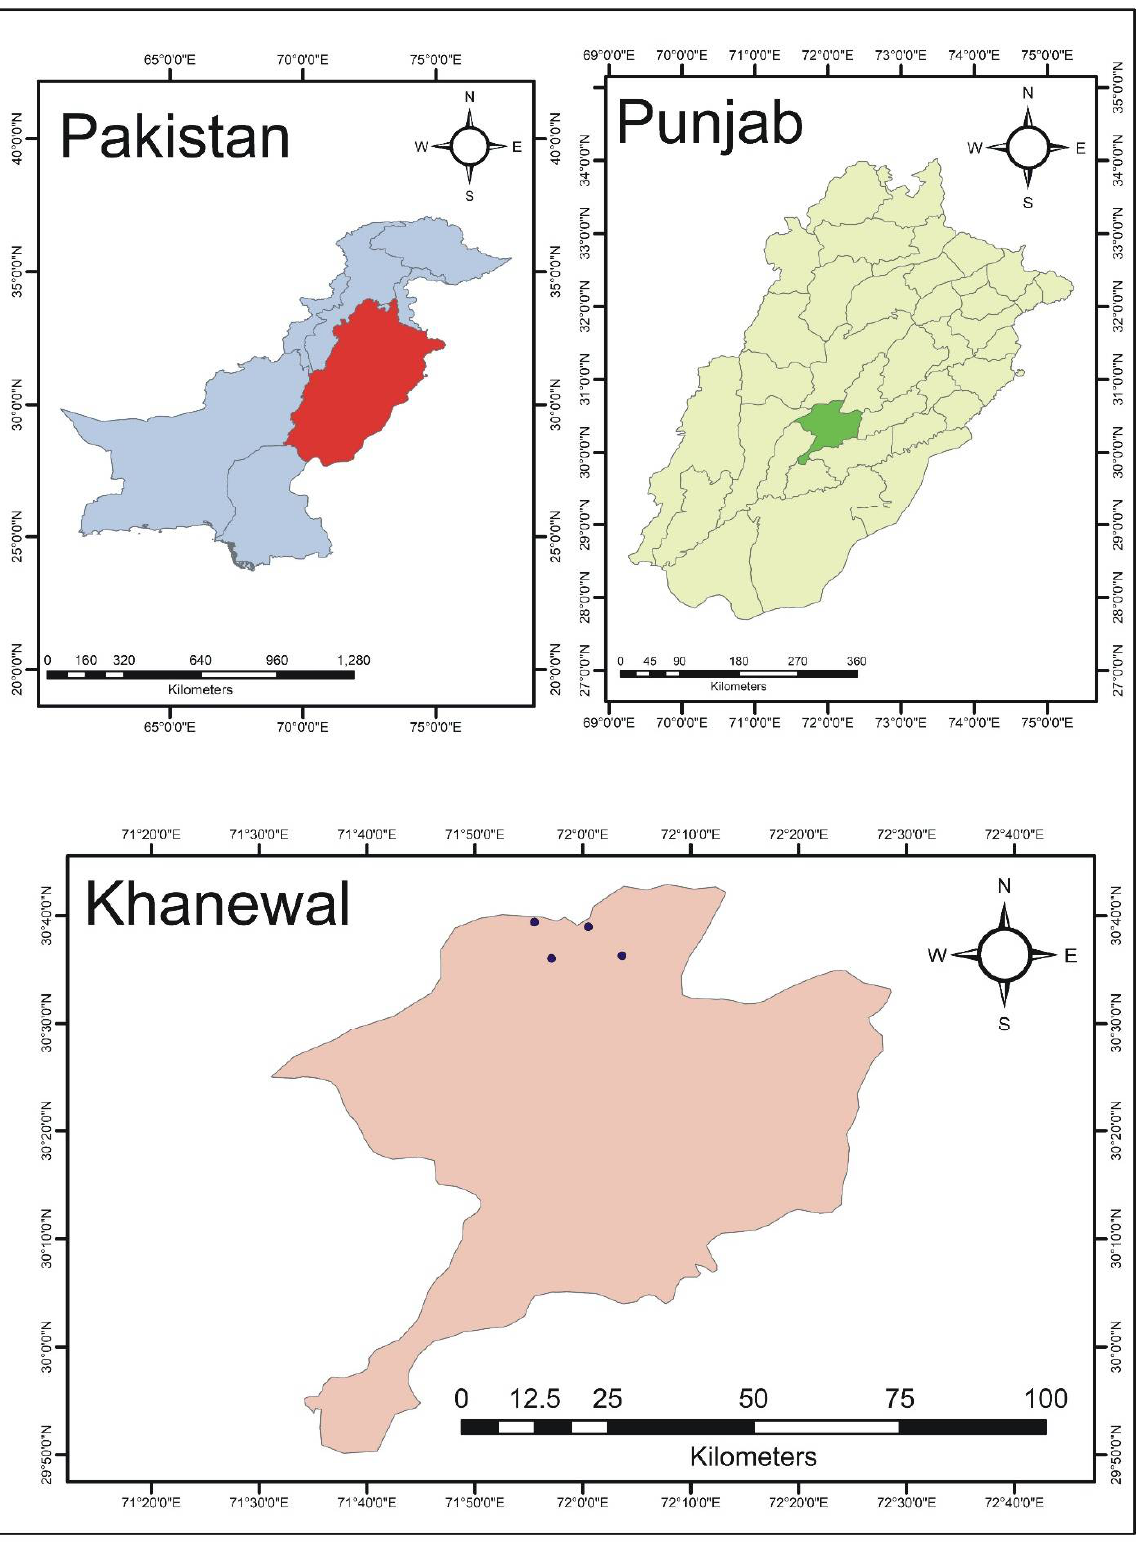
Figure 1. Map of the study area. Note: The dots show the exact location of the villages.